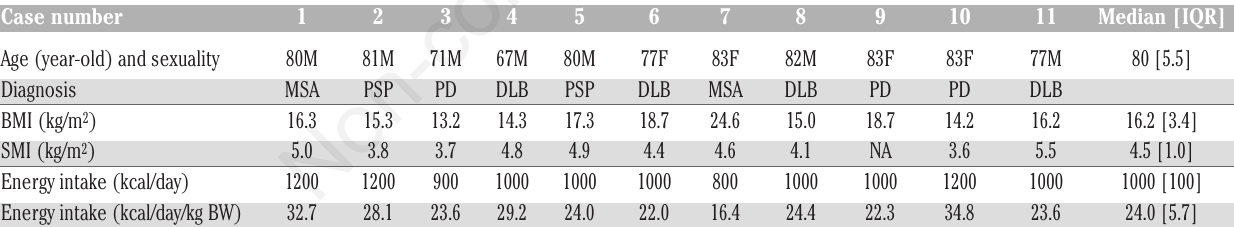
Table 1. Clinical features of the patients.